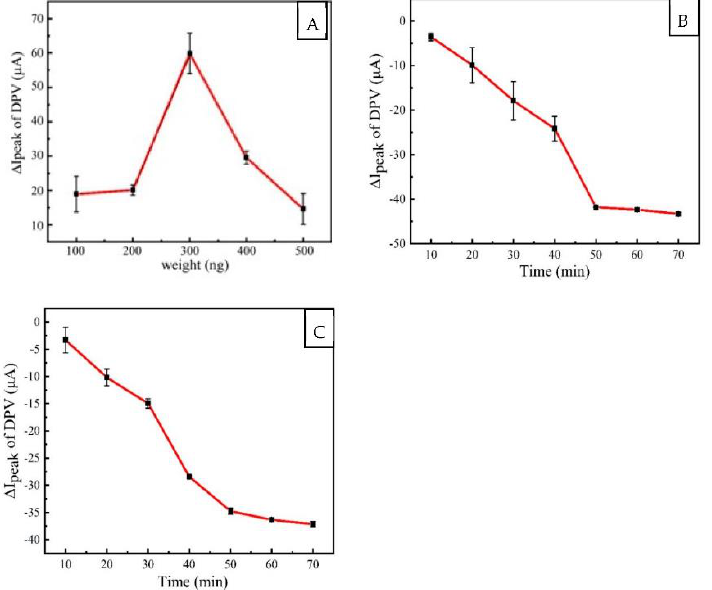
Figure 5. ( A ) The influence of the amount of AuNPs on the peak value for DPV current of PLL- BP/GCE. ( B ) Response of DPV to primer incubation. ( C ) The DPV response change graph of the aptamer incubation time in K 3 [Fe (CN) 6 ] mixed liquid system. Every point in the graph represents the mean of three successive measurements (n = 3) at each weight or time. (The length of the error bar, also known as the size of the standard deviation, describes how clustered data points are around the mean).